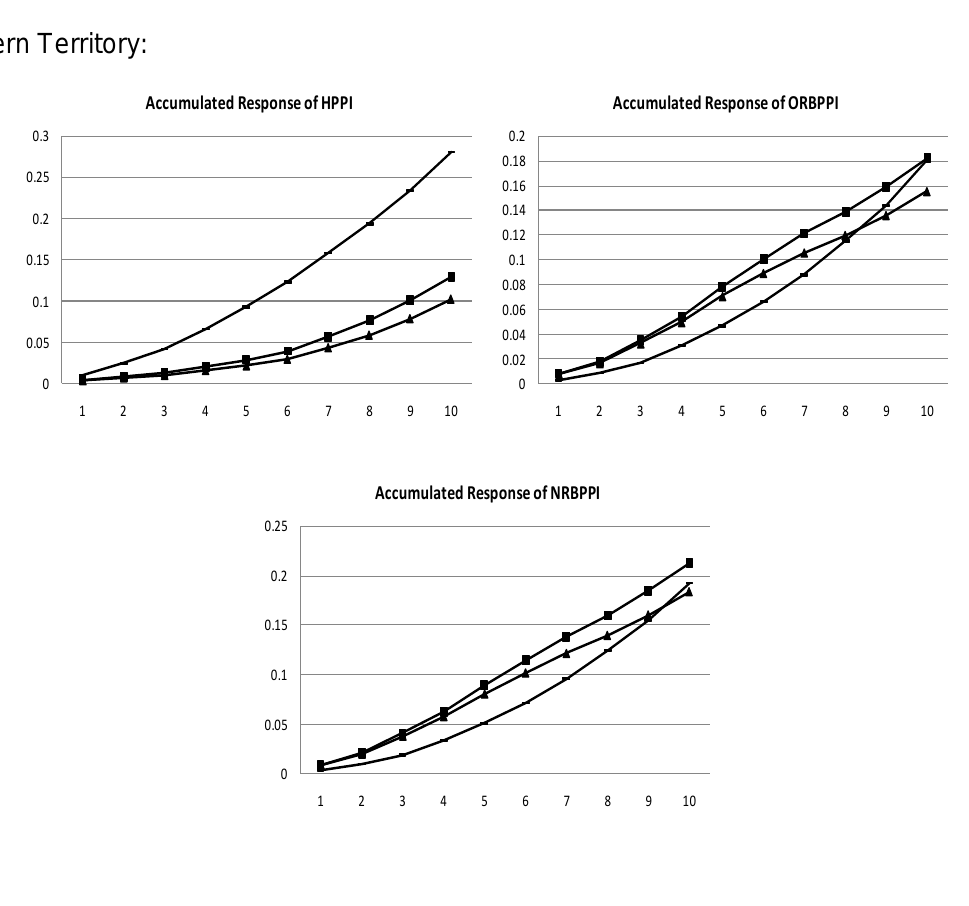
Liu, J and London, K A (2010) ‘Convergence among the sub-markets in Australian regional building construction sector’ , Australasian Journal of Construction Economics and Building, 10 (4)